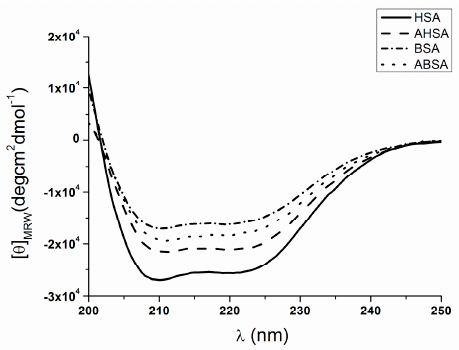
Figure 4. Far—ultra-violet circular dichroism (UV CD) spectra of native and aged human (HSA, AHSA) and bovine (BSA, ABSA) serum albumin; protein concentration was 1 × 10 − 6 mol/dm 3 . Table 3. The percentage (%) content of the secondary structure elements of HSA, AHSA, BSA, and ABSA calculated in the CD Multivariate SEE program using the standard calibration models; protein concentration was 1 × 10 − 6 mol/dm 3 . θ MRE at 222 nm